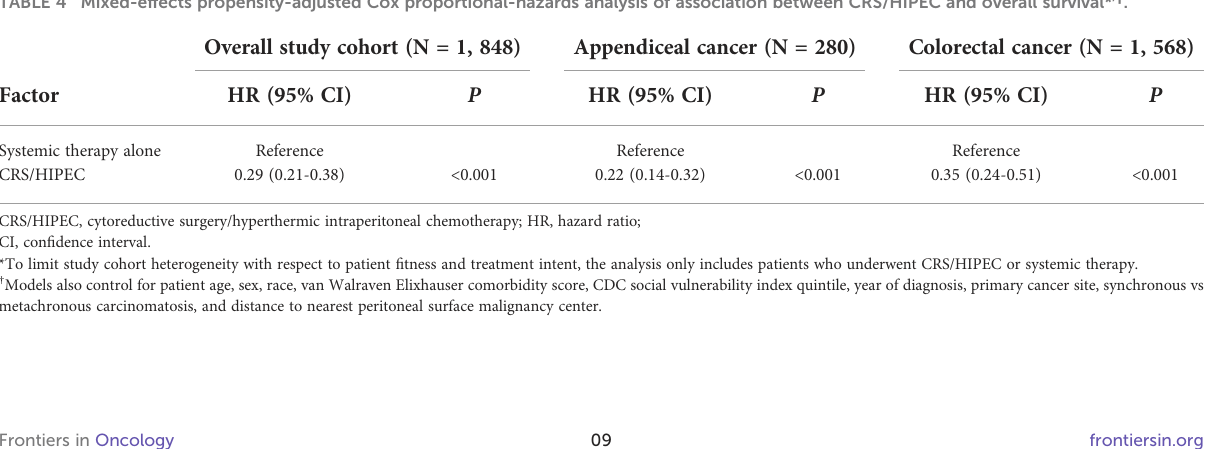
TABLE 4 Mixed-effects propensity-adjusted Cox proportional-hazards analysis of association between CRS/HIPEC and overall survival* , †